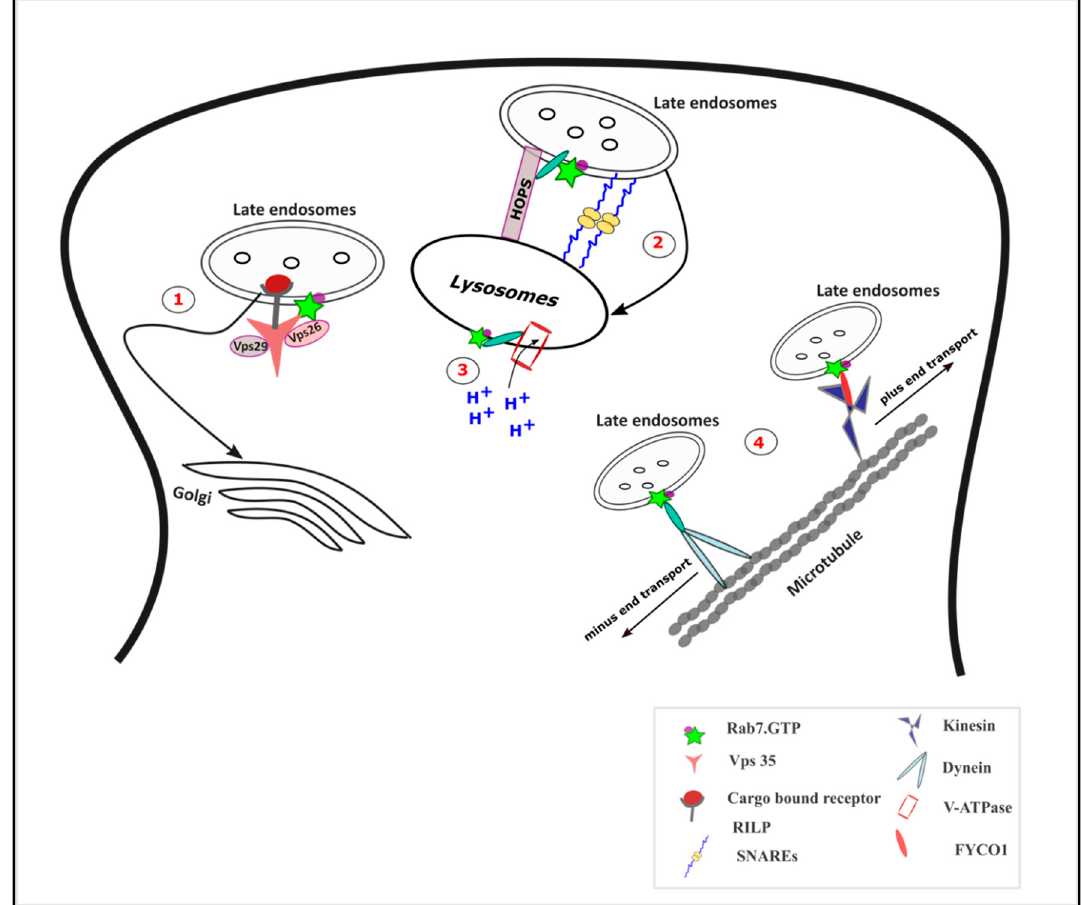
Figure 3. Functions of Rab7 in vesicular trafficking: ( 1 ) The retrograde transport of cargo to the Golgi complex is mediated by Rab7 via its interaction with the subunits of retromer complex especially vacuolar protein sorting-associated protein 35 (Vps 35). ( 2 ) Rab7-interacting lysosomal protein (RILP) interaction with the Homotypic fusion and Protein Sorting (HOPS) complex mediates the endosome-lysosome fusion along with the SNAREs. ( 3 ) The Rab7-RILP complex regulates the function of Vacuolar-ATPase (V-ATPase) and hence in lysosomal acidification. ( 4 ) Rab7, by interacting with RILP, mediates the minus end transport of the late endosomes, while its interaction with FYVE and coiled-coil domain autophagy adaptor-1 (FYCO1) mediates the plus end directed transport.